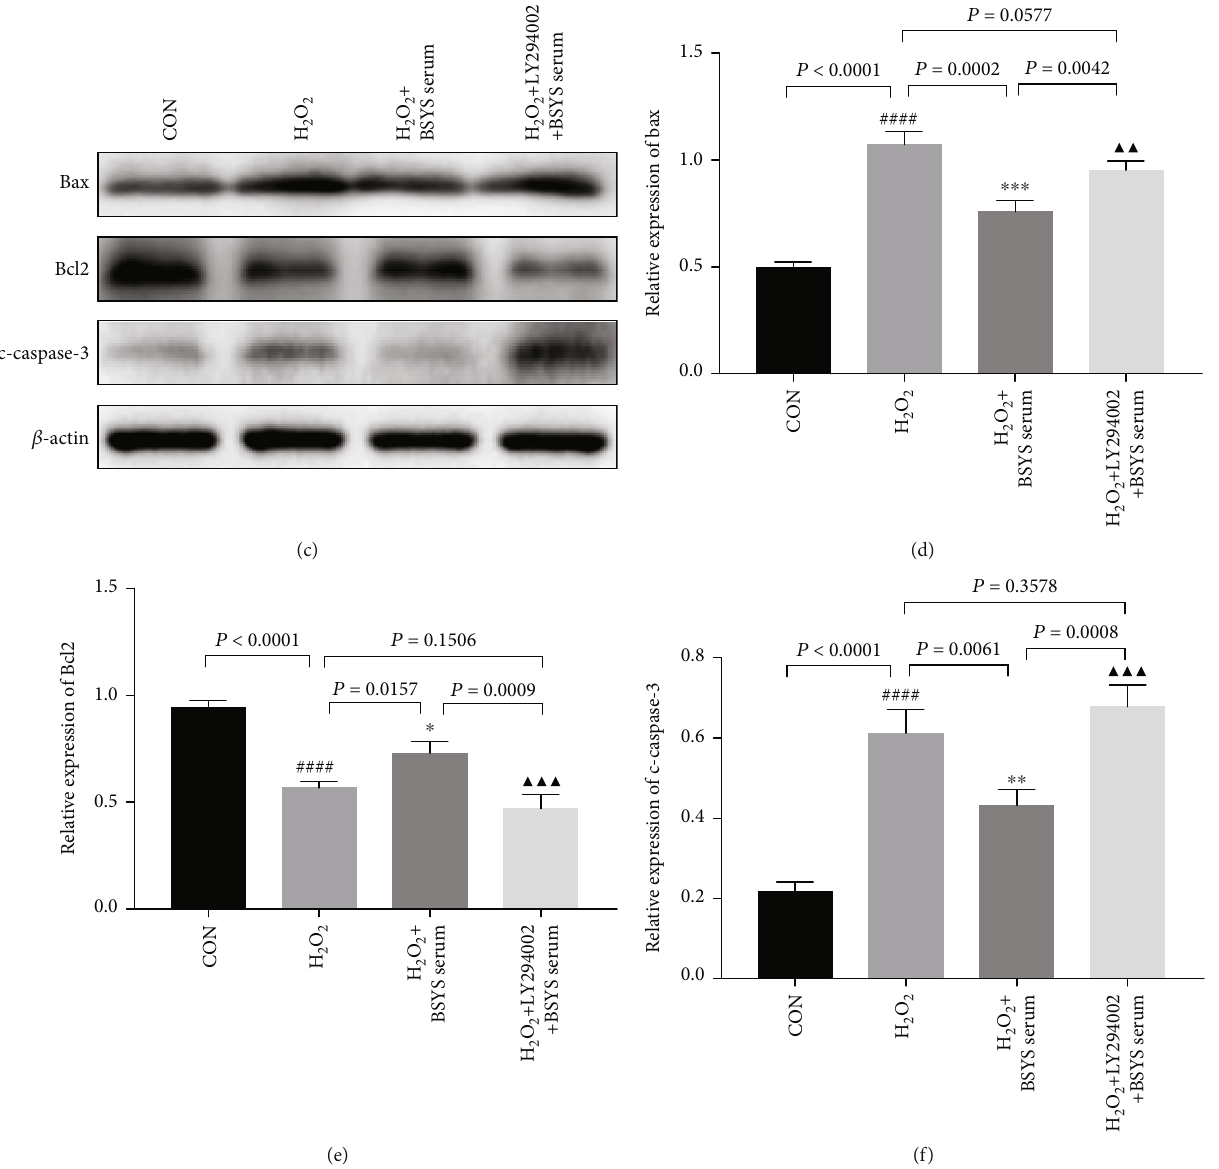
Figure 12: BSYS serum inhibits H O -induced apoptosis of OLN-93 cells via regulating Akt phosphorylation. (a, b) The apoptotic cells (red 2 2 fl uorescence) were detected by TUNEL, and the nuclei (blue fl uorescence) were stained by DAPI. Scale bar = 25 μ m . (c) – (f) Representative blots and statistical graphs of relative protein expression of Bax, Bcl-2, and c-caspase3 in OLN-93 cells. Data are presented as means ± SD , compared with the CON group, #### P < 0 : 0001 ; compared with the H O group, ∗ P < 0 : 05 , ∗∗ P < 0 : 01 , ∗∗∗ P < 0 : 001 , ∗∗∗∗ P < 0 : 0001 ; and 2 2 compared with the H O + BSYS serum group, ▲▲ P < 0 : 01 , ▲▲▲ P < 0 : 001 , ▲▲▲▲ P < 0 : 0001 2 2